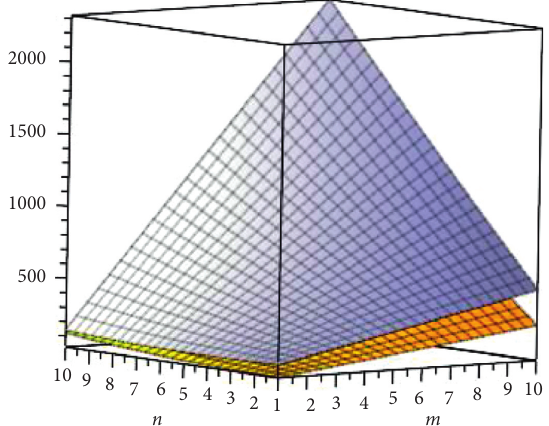
Figure 9: Graph for ( α � 2 ) 16 2 ( nm − n ) + 16 2 ( mn − m ) + 6 m ( 4 m − 6 ) 2 + 16 2 ≤ R ( 4 m − 6 ) 2 + 4 2 .